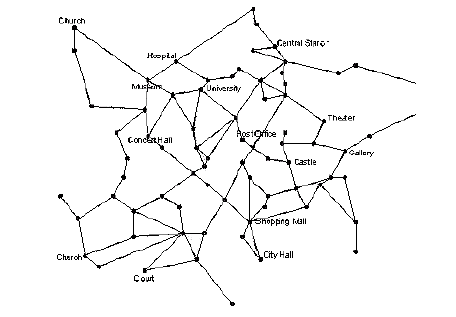
Figure 1. An example graph modelling a city center from [25] nodes choose destinations makes this approach fail to comply with the third, fourth, and sixth characteristics of human mobility